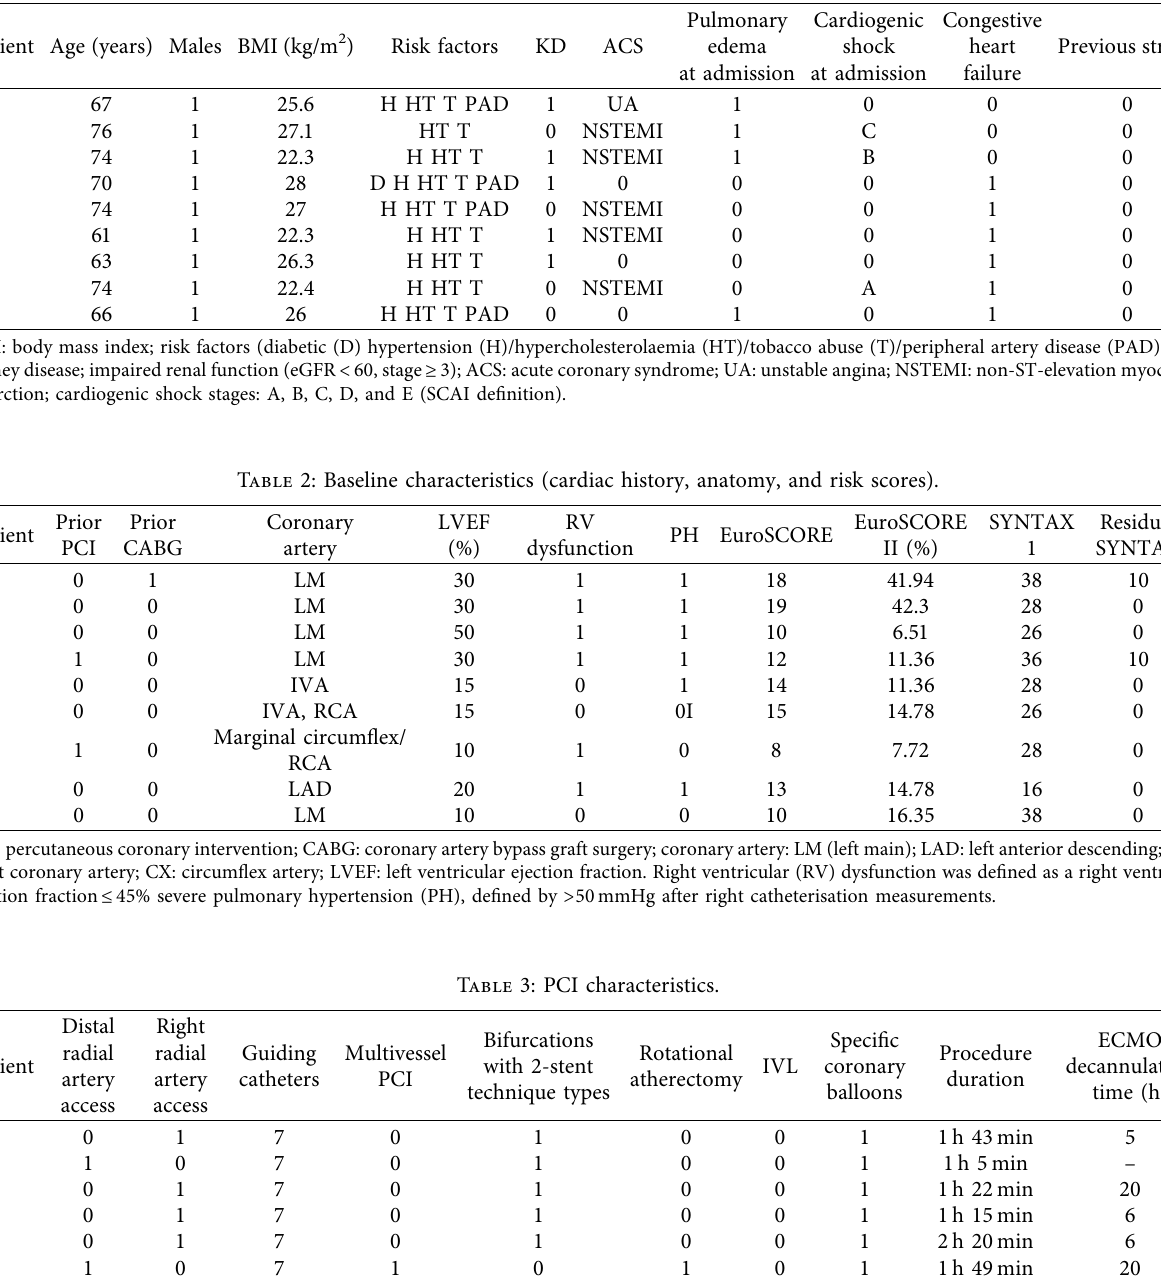
Table 1: Baseline clinical characteristics.